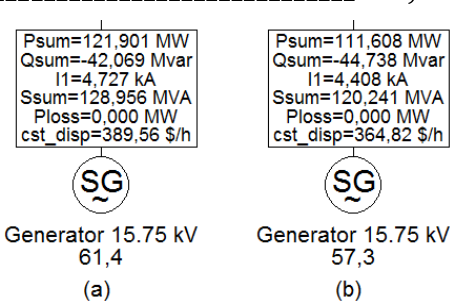
Fig. 7. The influence of wind generation on fuel costs: without wind park (a), with wind park (b). The generation of active power in the model without wind park is P G = 121.091 MW and the costs are cst_disp = 389.56 USD/h. With wind park, generator output and cost of one hour of operation are reduced. However, the price for 1 MWh in the first case is C G = 389.56 (USD/h) / 121.901 (MW) = 3.20 (USD/MWh); in the model with wind park, this price is C G+W = 364.82 (USD/h) / 111.608 (MW) = 3.27 (USD/MWh). Generally, more loaded generating units